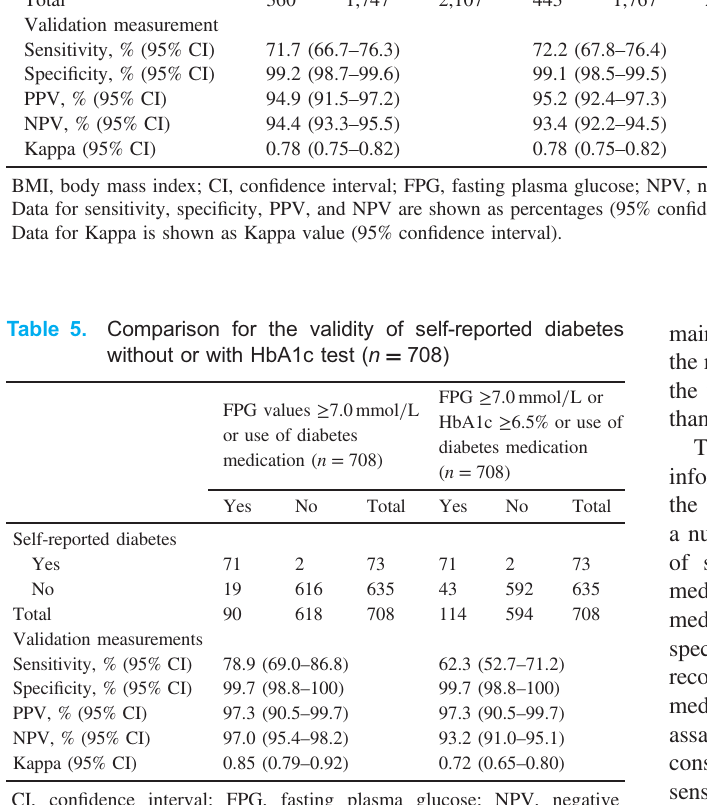
CI, con fi dence interval; FPG, fasting plasma glucose; NPV, negative predictive value; PPV, positive predictive value. Data for sensitivity, speci fi city, PPV and NPV are shown as percentages (95% con fi dence intervals). Data for Kappa is shown as Kappa value (95% con fi dence